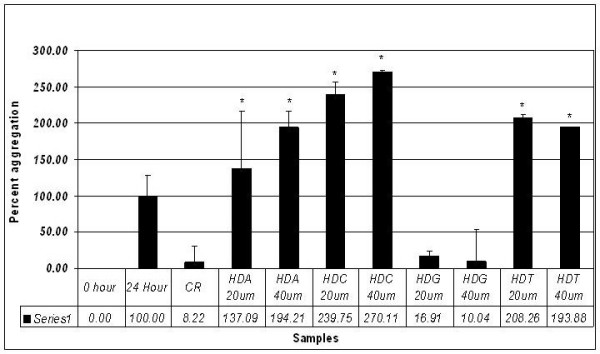
Graphic depiction of blots carried out to test monotonic 20-mers. Average aggregation levels, representative of 5 independent experiments with standard deviation and average values (Series 1) presented. *, denotes significance p < 0.05 as compared to Congo Red (control) as determined by a one way ANOVA with Tukey's post hoc test.